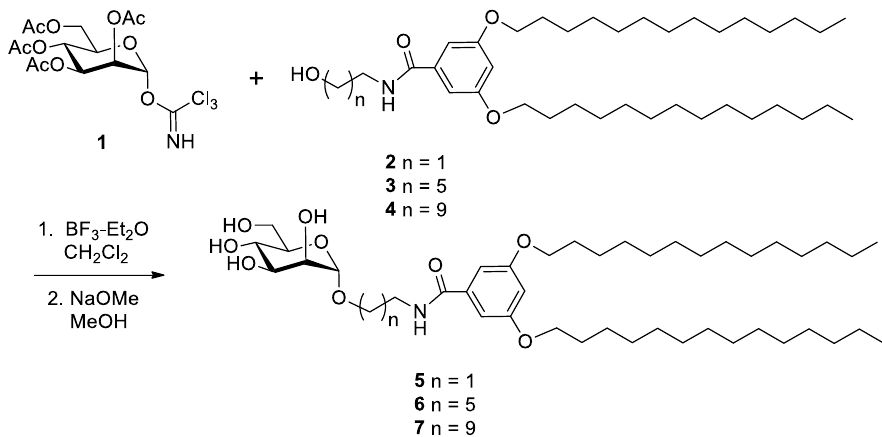
Scheme 2. Synthesis of mannosylated neoglycolipids mounted on an aromatic scaffold [22].